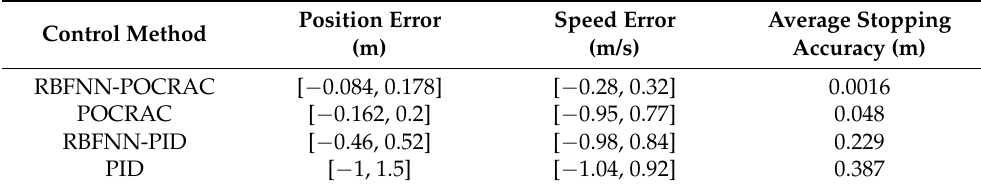
Table data obtained by 100 simulation runs.